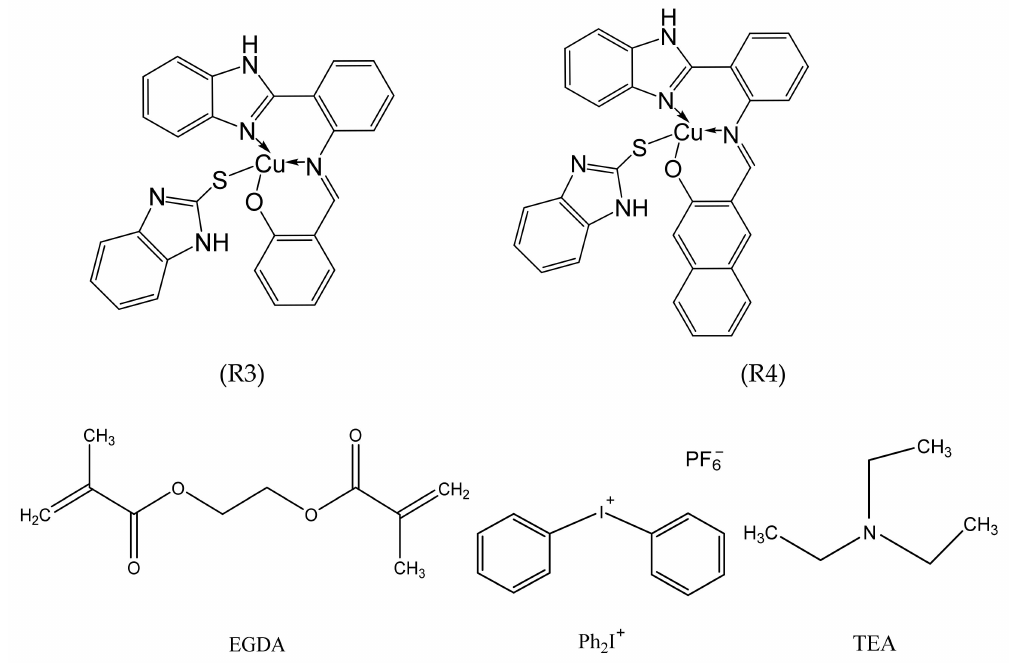
Scheme 1. Structures of R3 and R4 copper II complexes and the monomers and additives used